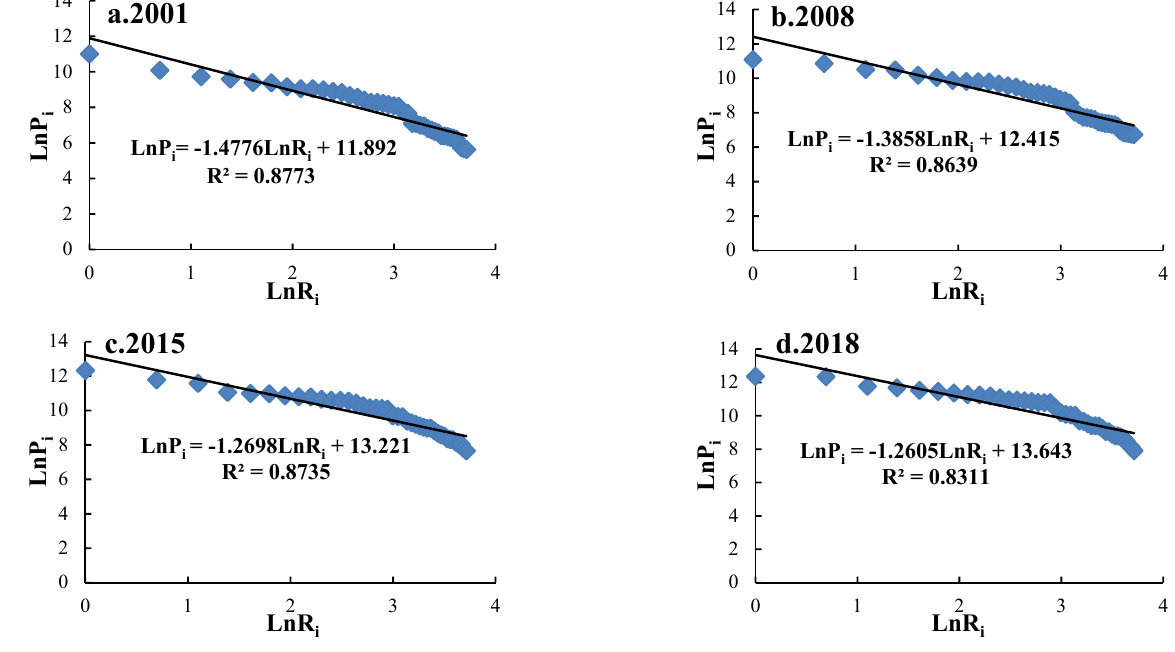
Figure 4. The rank-scale distribution of cities in the Yangtze River Delta defined by the number of startups ( a ) in 2001, ( b ) in 2008, ( c ) in 2015, and ( d ) in 2018.